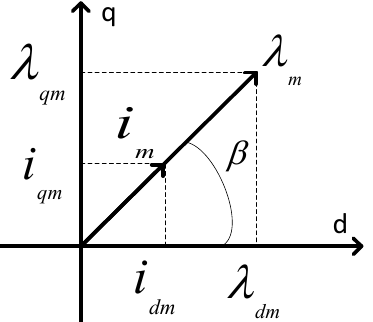
0 0.5 1 1.5 Figure 5. The static and dynamic inductances as a function of the magnetizing current. Energies 2022 , 15 , x FOR PEER REVIEW 10 of 21 Furthermore, if we assume a sinusoidal distribution of the windings, the flux and the magnetizing current can be considered as space vectors. Since the hysteresis is neglected, these two vectors are in phase. Therefore, at a given moment, their position can be identified with respect to the axis d and chosen as a reference, using an angle α , Figure 6.